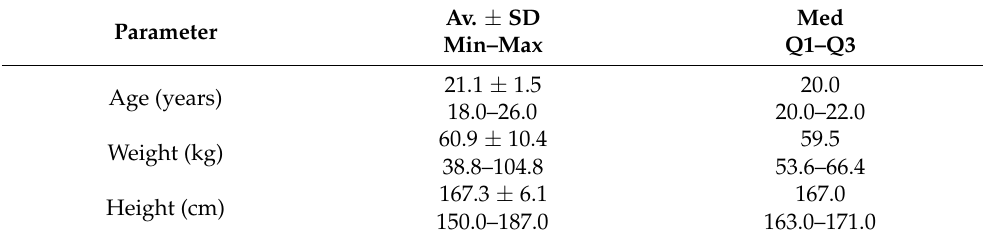
Table 1. Characteristics of study